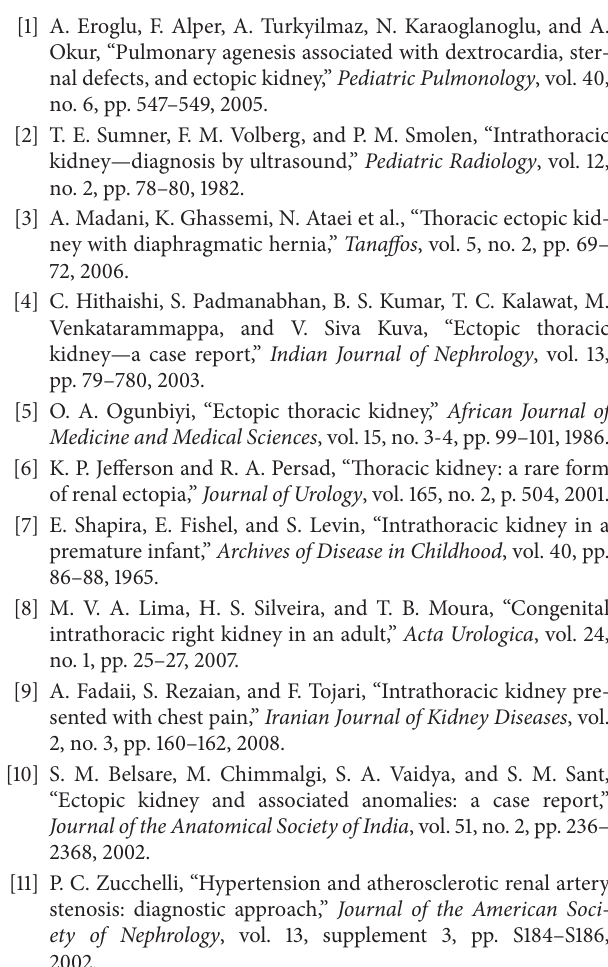
also been reported [4]. They are usually asymptomatic and only discovered on routine medical examinations, though there is a report of chest pain occurring in a patient with a left intrathoracic kidney [9]. In this patient, investigations for a possible renovascular cause for her very high blood pressure recordings led to the discovery of a left thoracic ectopic